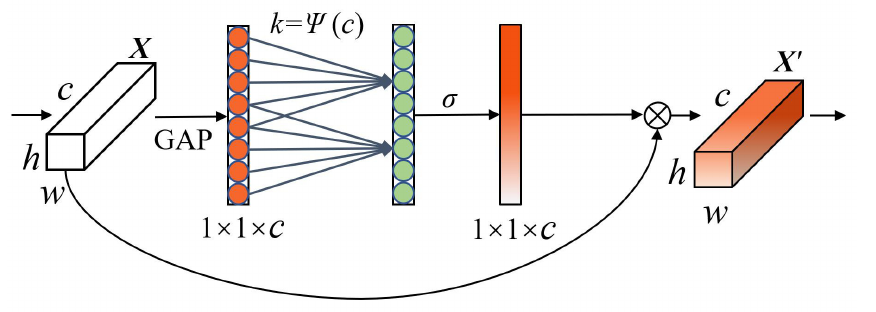
Figure 2. ECA attention module.